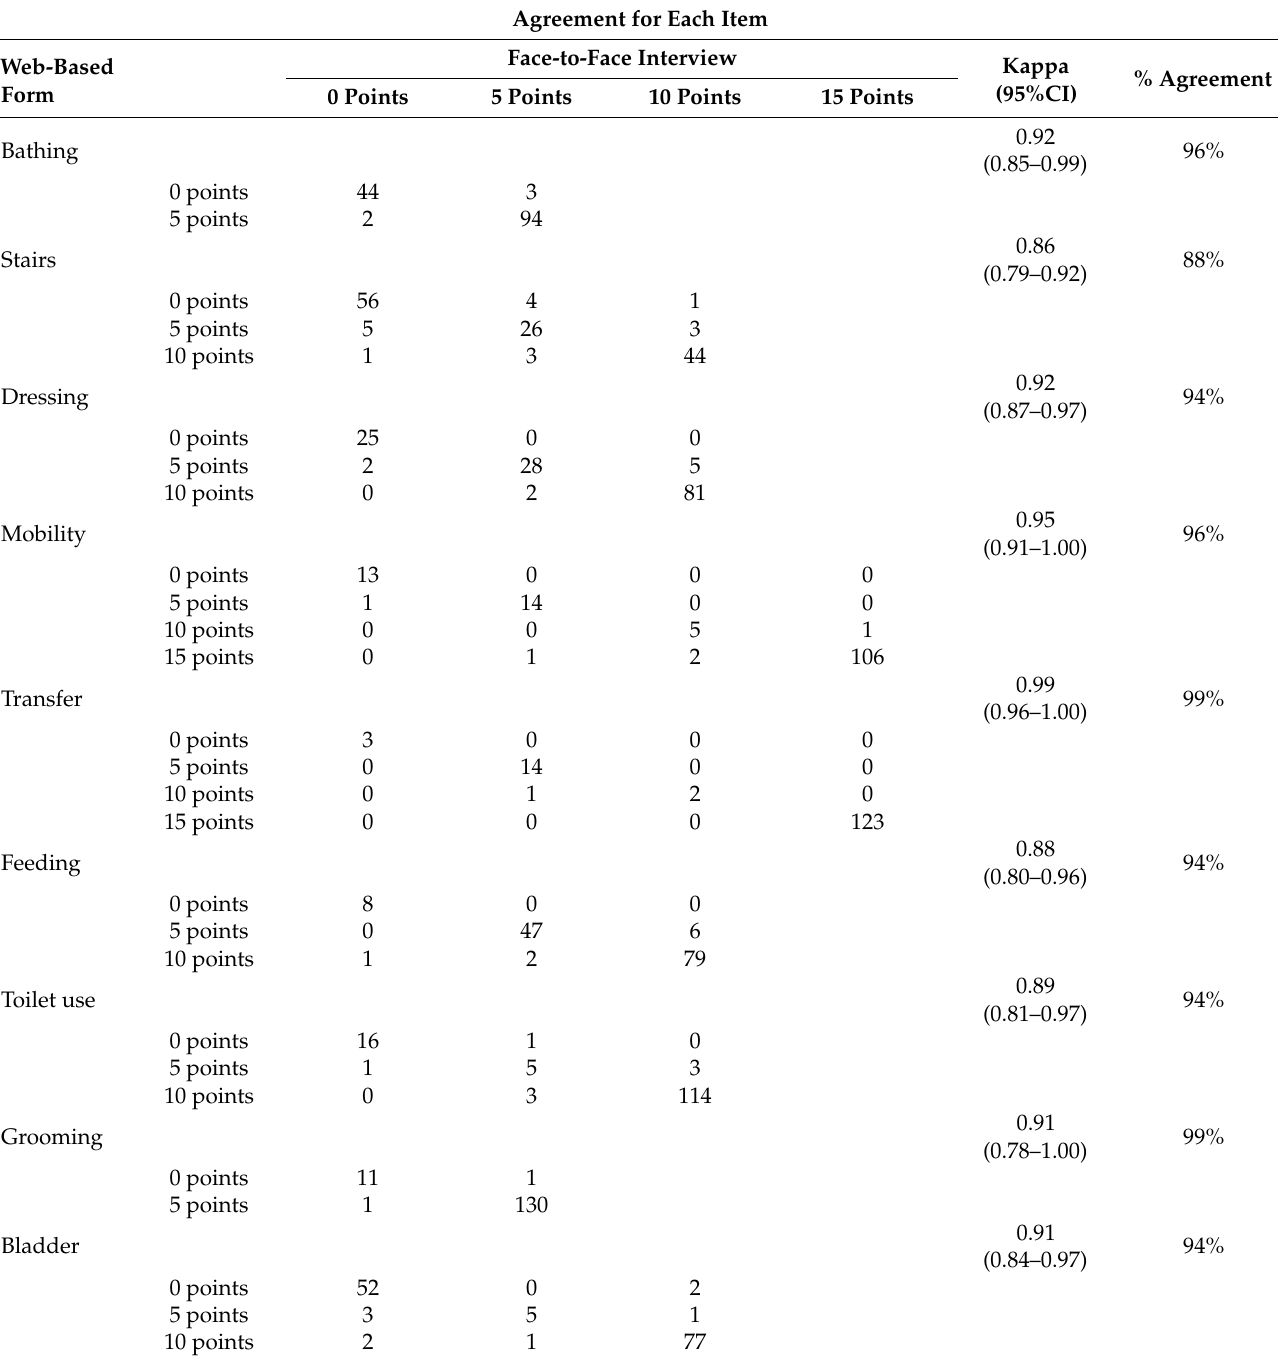
Table 2. Agreement between the web-based form and the face-to-face interview of the Barthel index for each item and for the total score of the categorical